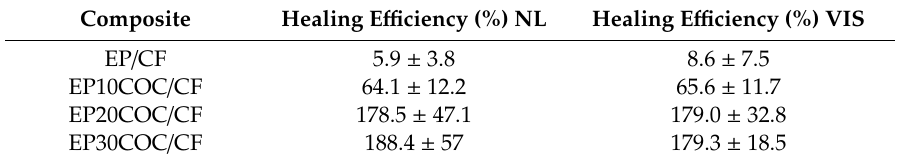
Table 4. Healing e ffi ciency of laminates calculated by G Ic values corresponding to NL and VIS Table 4. Healing efficiency of laminates calculated by G Ic values corresponding to NL and VIS points.